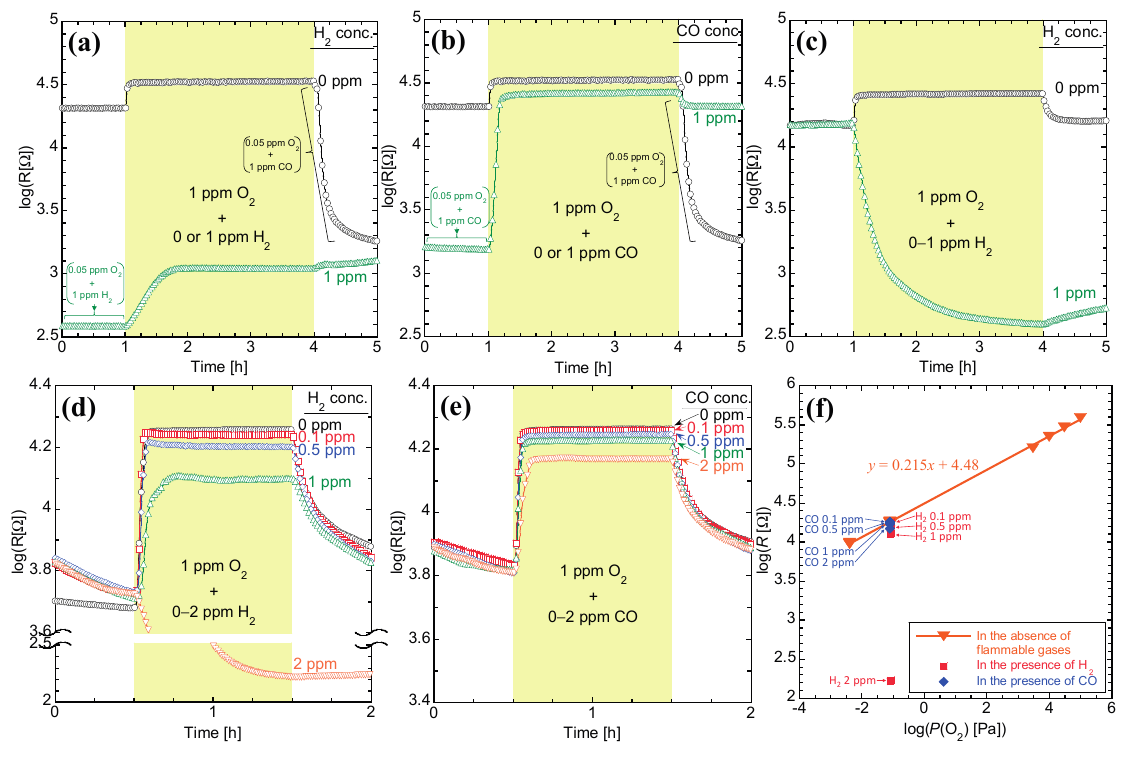
Figure 6. Dynamic resistance response of ( a , b ) CeZr10; ( c ) CeZr10/Al 2 O 3 /CeZr10; and ( d , e ) CeZr10/Al 2 O 3 /Pt-CeZr10 to 1 ppm oxygen in the presence of flammable gases ( a , c , d = hydrogen; b , e = carbon monoxide); ( f ) the linear regression equation from resistances of CeZr10/Al 2 O 3 /Pt-CeZr10 for the converted oxygen concentrations. The resistances in ~1 ppm oxygen are plotted from Figure